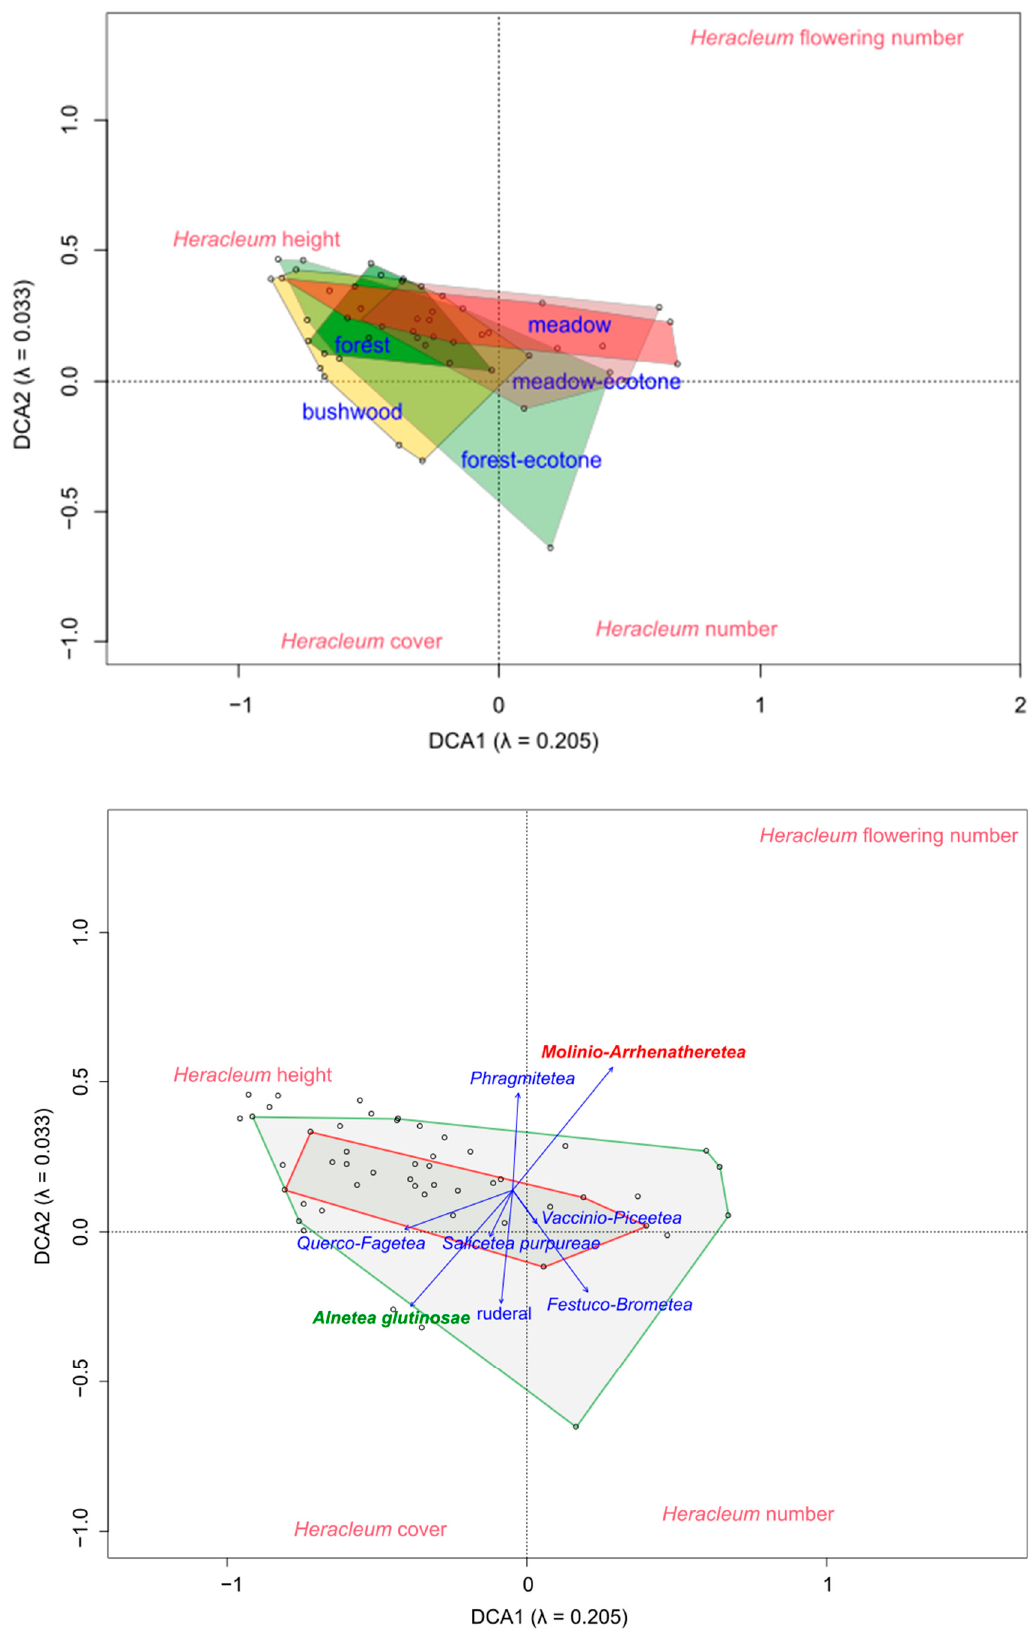
Figure 5. The relationships between habitats from five categories ( above ) or plant communities ( below ; marked in bold and polygon if significant) and invasiveness traits of Caucasian hogweeds measured during the third field visit in the 50 m radius study plots.